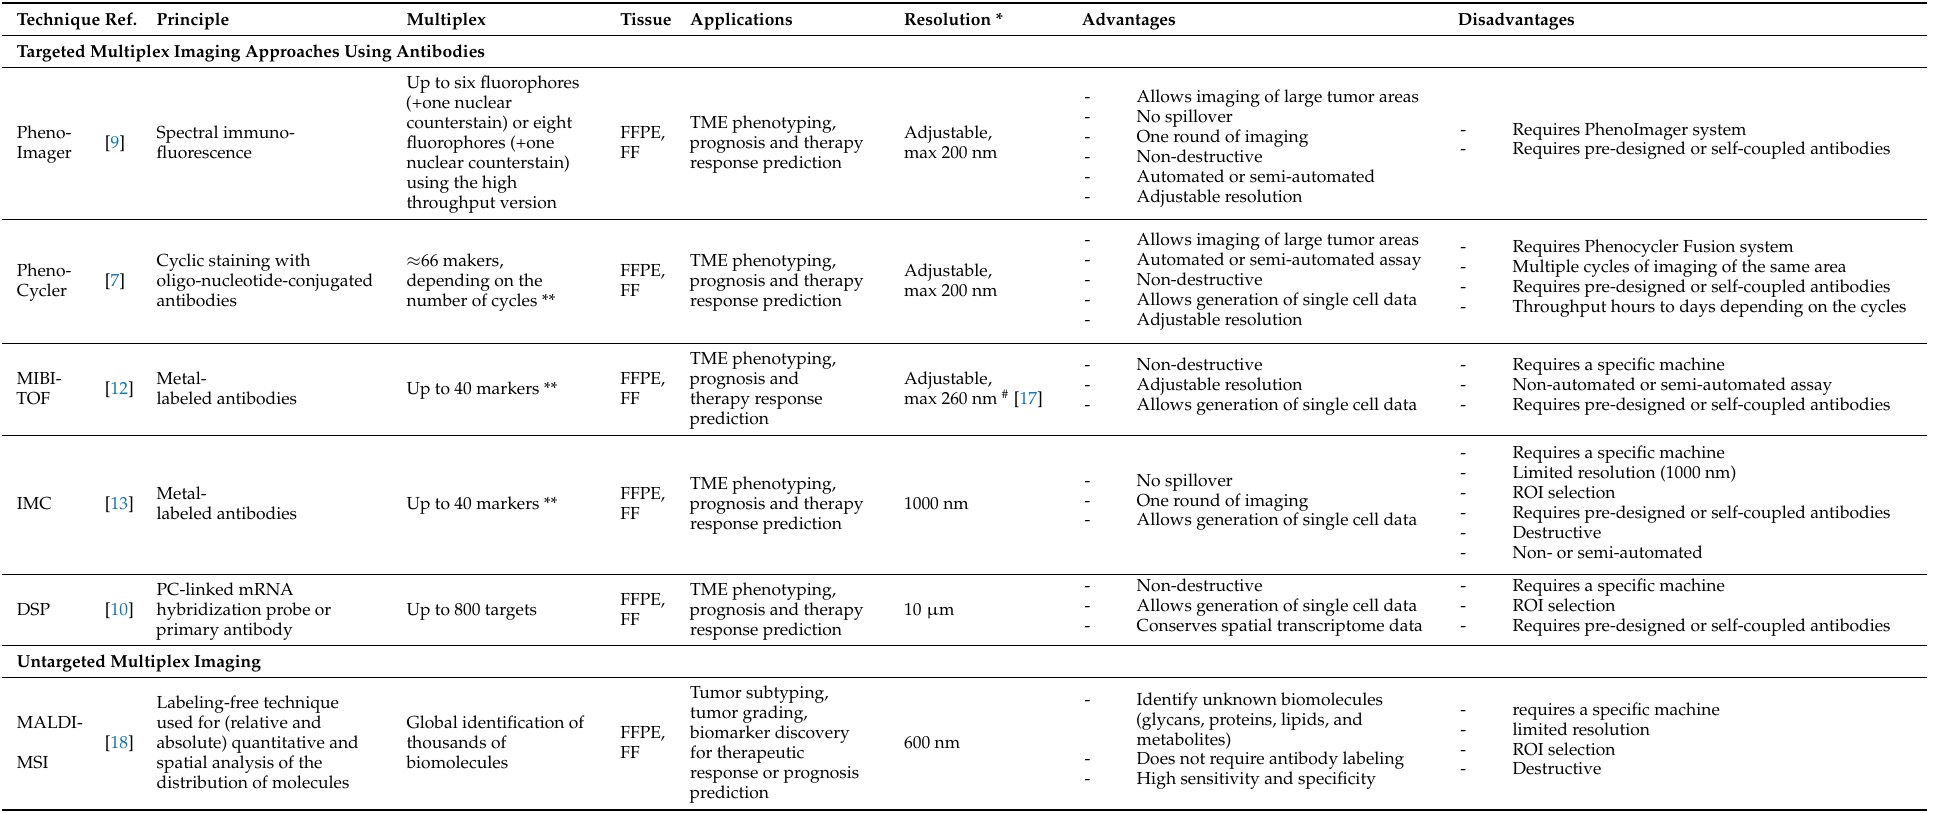
Table 1. Summary of technical details, advantages, and disadvantages of each multiplex imaging